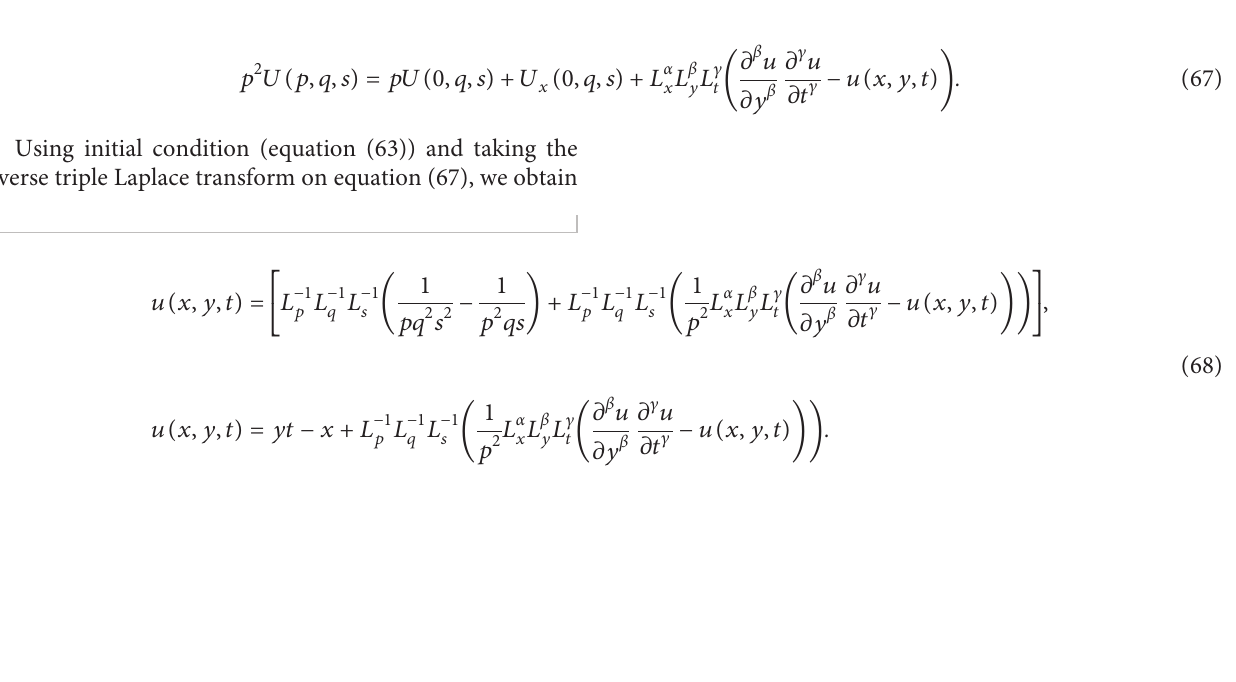
Figure 2: 3D plot of equation (60) for α � 0 . 75 ; β � 0 . 90 ; y �